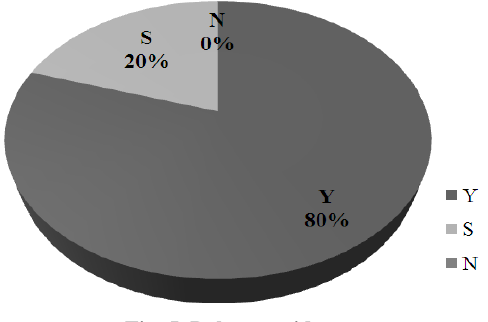
Fig. 6. Cost escalation avoidance Fig. 5. Delays avoidance Figure 6 shows the responses relating to Figure 5 shows the responses relating to respondents who believe that cost escalations in project execution can be avoided during turnarounds. The results indicated that only 70% of the respondents agreed that cost escalation can be avoided and 10% disagreed and 20% are uncertain and no one agreed.